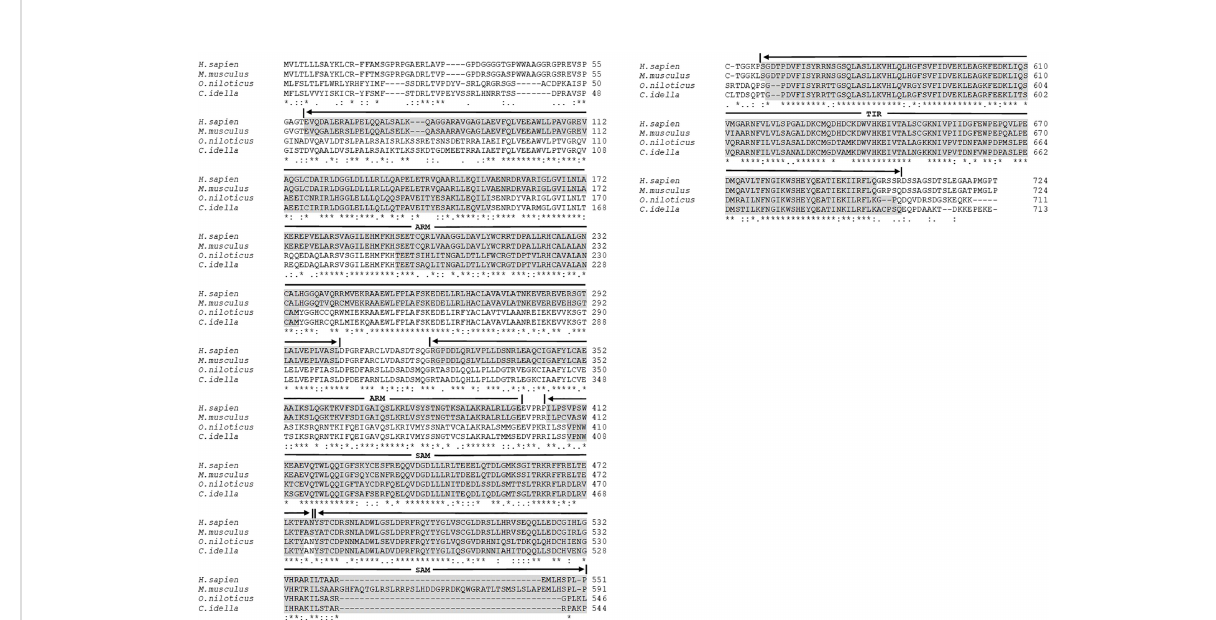
FIGURE 3 Multiple alignments of SARM1 amino acid sequences from Oreochromis niloticus , Homo sapiens , Mus musculus , and Ctenopharyngodon idella . The accession numbers of the amino acid sequences are provided in Supplementary Table 2. The dashes in the sequences indicate gaps introduced to maximize alignment. Identical (*), similar (.), and highly conserved (): residues identi fi ed by the ClustalW program are indicated. Five domains are labeled and shaded in grey. ARM, Armadillo/beta-catenin-like repeats; SAM, Sterile alpha motif; and TIR, Toll - interleukin 1 - receptor.